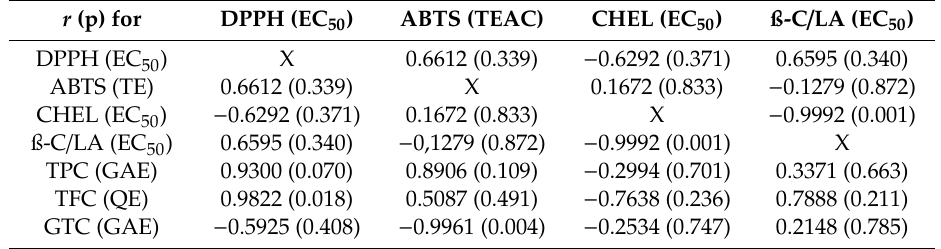
Table 6. Pearson’s correlation coe ffi cients between phenolic content and antioxidant activity tests of P. rotundifolia leaves. Trolox Equivalent Antioxidant Capacity (TEAC), β -carotene / linoleic acid bleaching assay ( β -C /